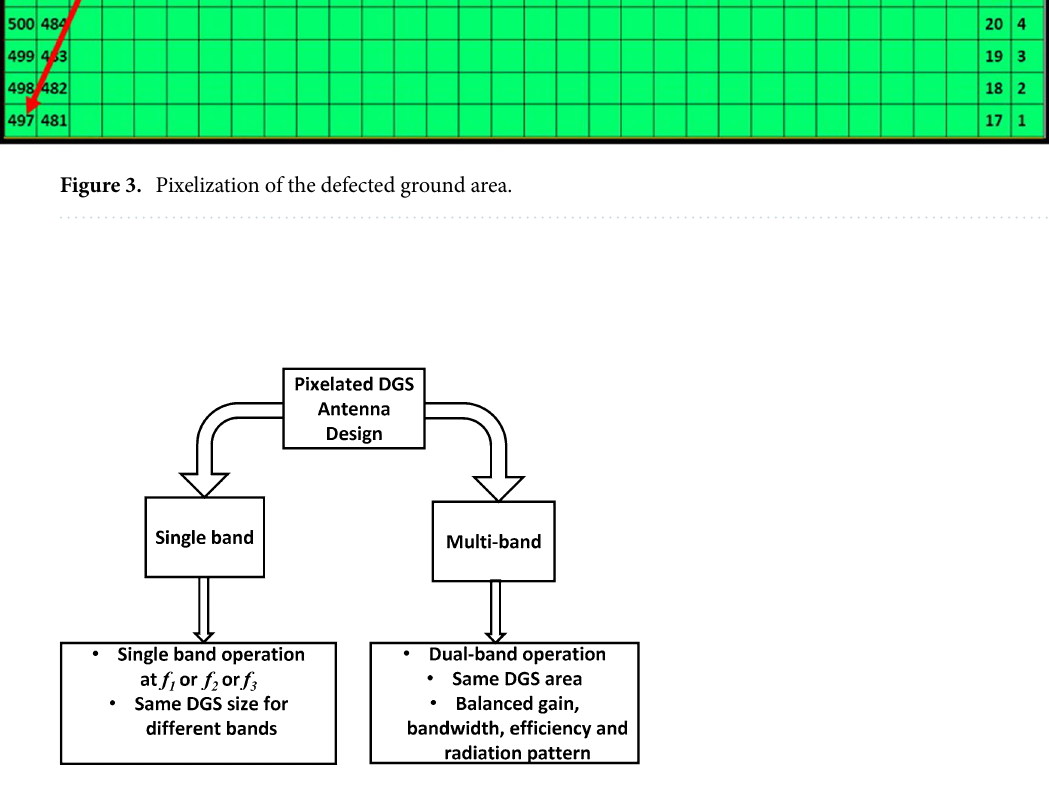
Figure 4. Single-band or multi-band antenna design flexibility using pixelated DG